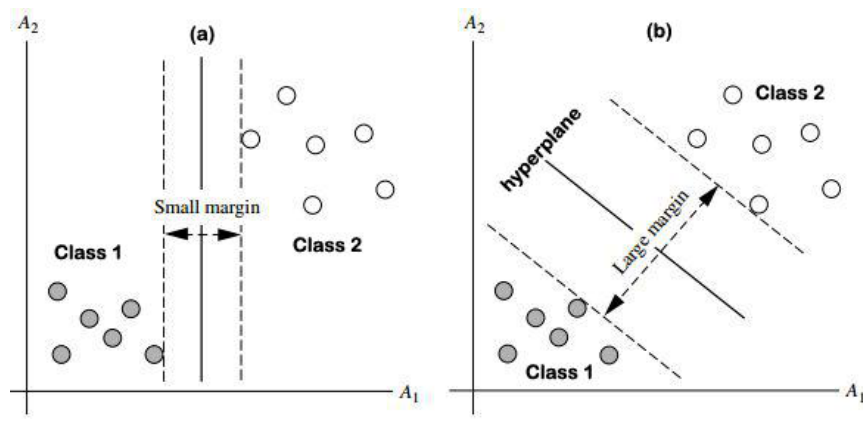
Figure 2. The Illustration of Hyper plane in SVM